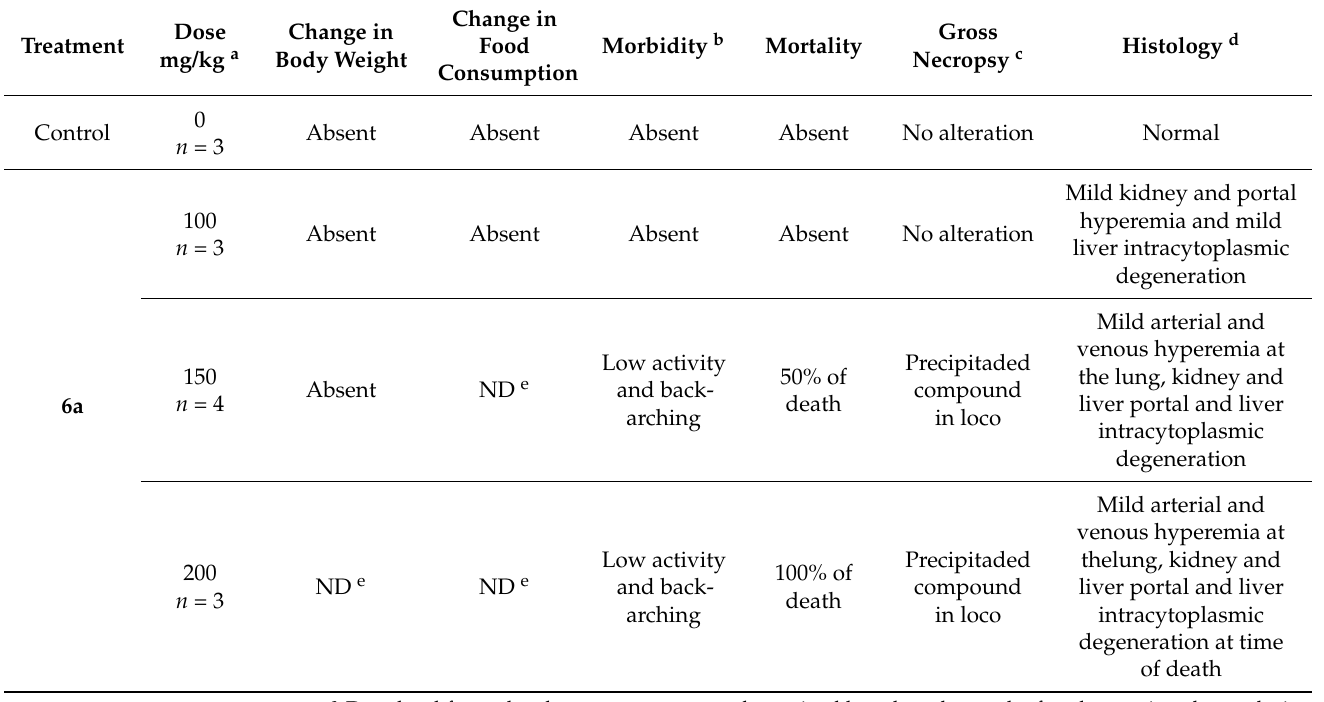
Table 3. Acute toxicity study: morbidity, mortality, gross organs necropsy and histology of mice treated with compound 6a . For more information and results, see Supplemental Table